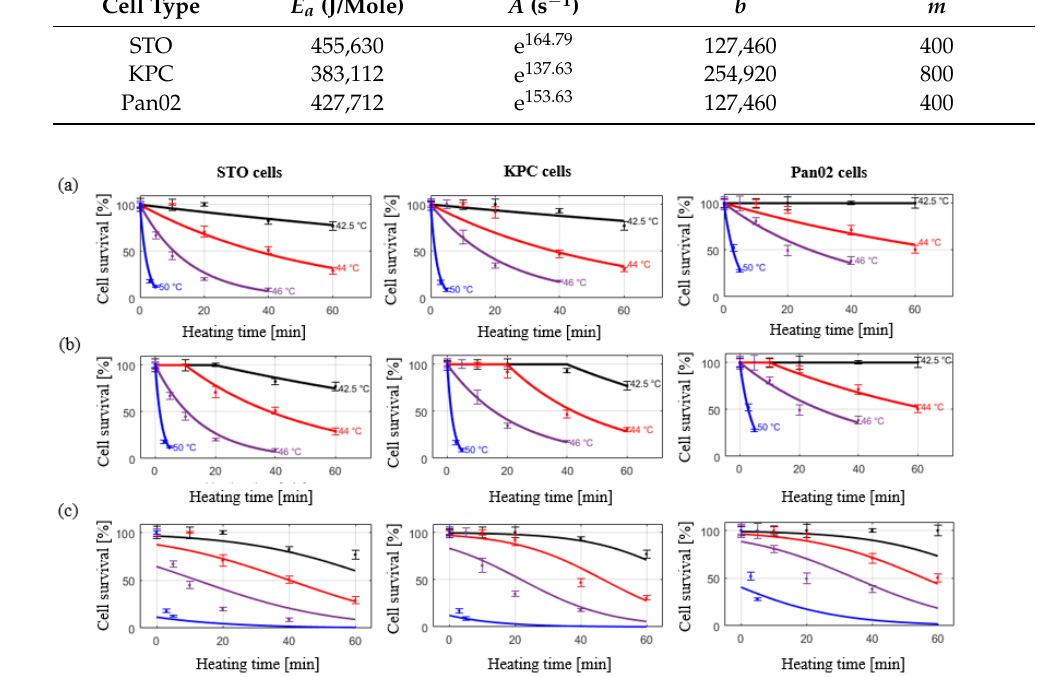
Figure 5. Cell viability assessed at 24 h post in vitro hyperthermia exposure in KPC, Pan02, and STO cell lines. Markers indicate measured data points. ( a ) Solid lines represent the simple Arrhenius model; ( b ), solid lines represent the improved Arrhenius model with time delay; ( c ) solid lines represent the predictive two- state model.